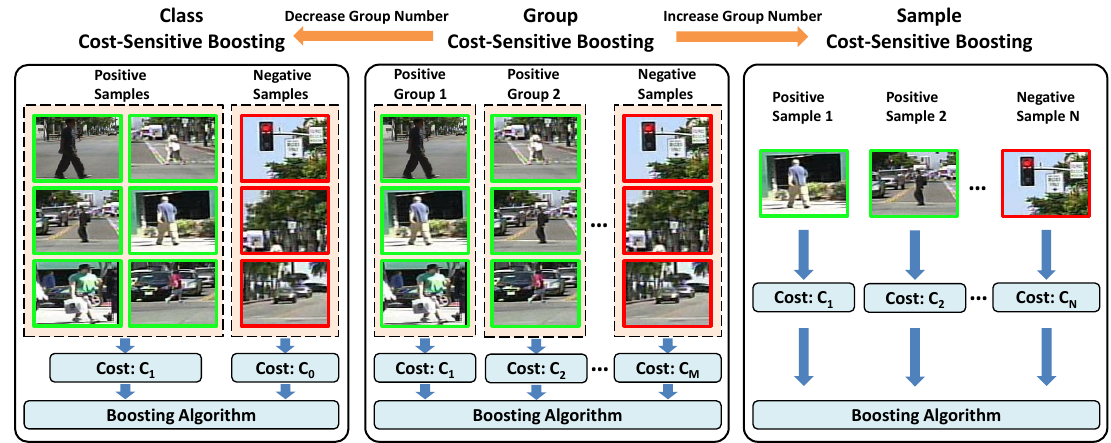
Figure 2. Comparison of different cost-sensitive boosting